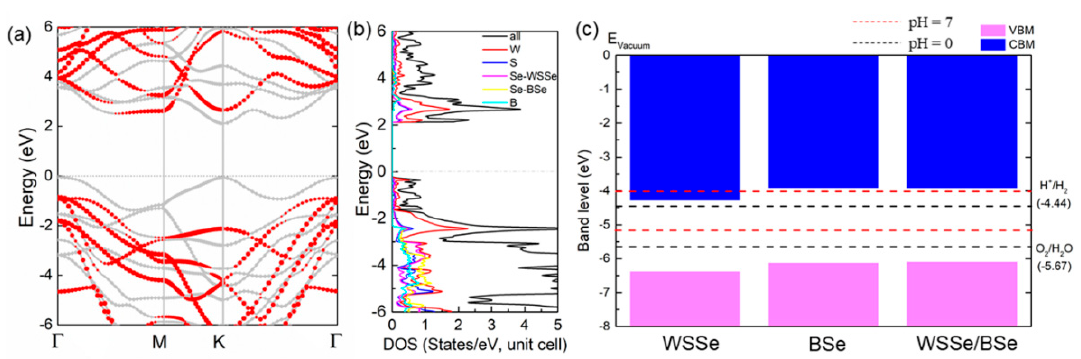
Figure 4. ( a ) The projected band structure and ( b ) the projected density of states of the WSSe/BSe vdW heterostructure; ( c ) the band edge positions of the WSSe, BSe and the WSSe/BSe vdW heterostructure, and the potentials of redox at pH 0 and 7 to decompose water are also shown.